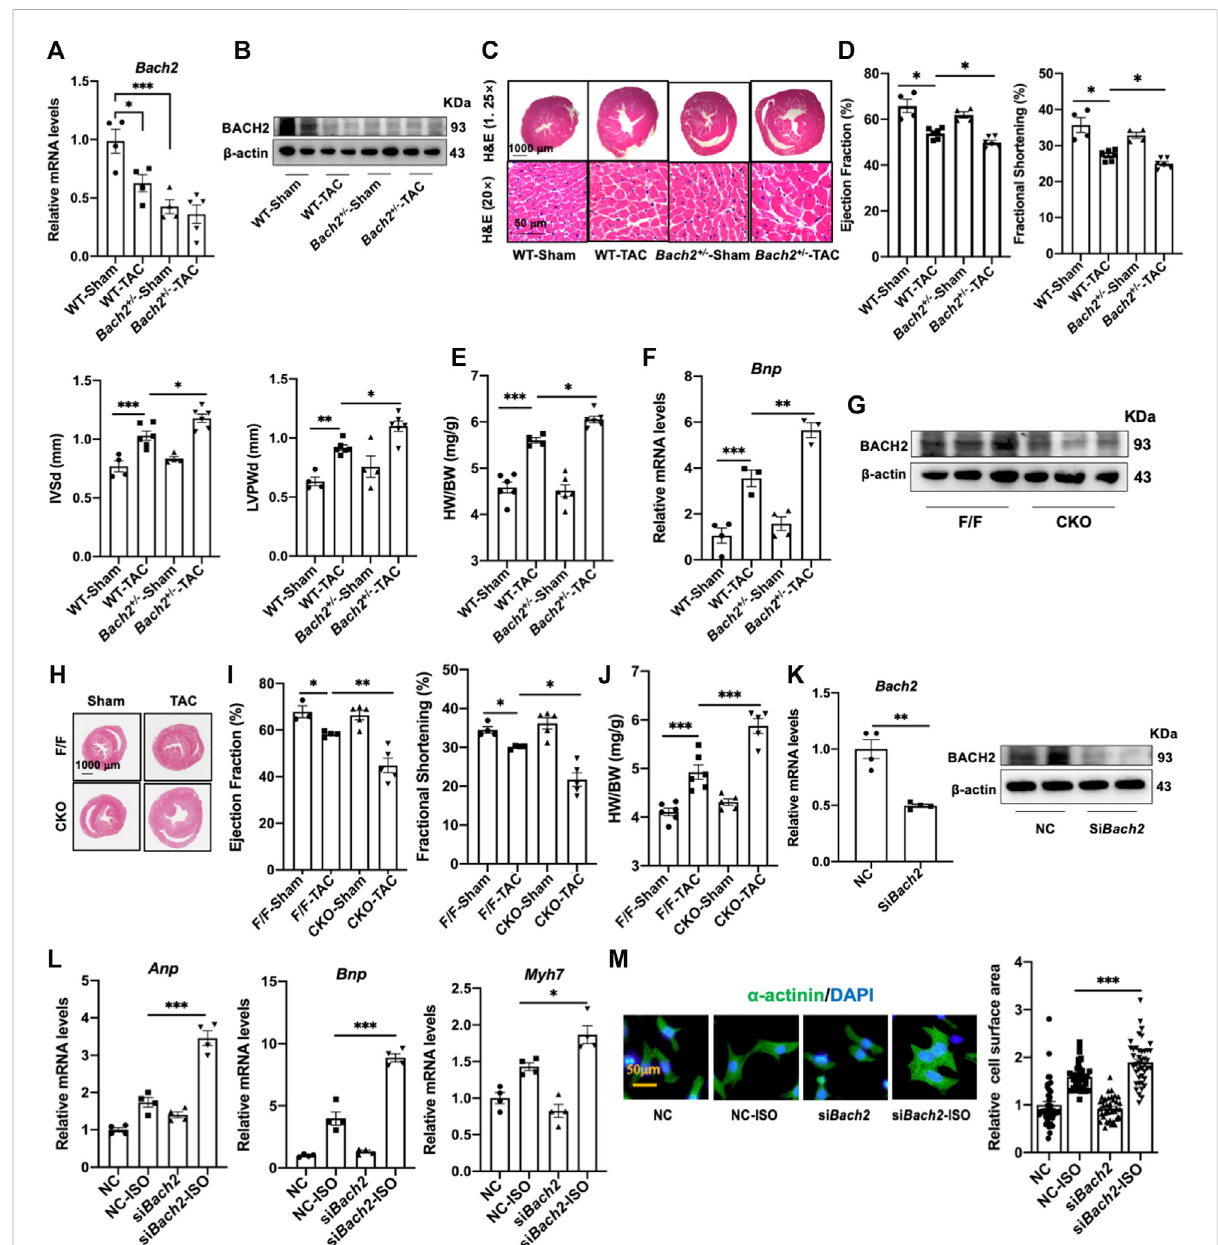
BACH2 de fi ciency exacerbates myocardial hypertrophy and dysfunction. (A – B) The Bach2 mRNA and protein expression levels. (C) H & E stain showed the hypertrophic hearts. (D) Echocardiographic analyses of cardiac wall thickness and function. (E) Heart weight/Body weight (HW/BW). (F) RT-qPCRanalysesofthe Bnp mRNAexpressionlevel. (G) TheproteinexpressionlevelofBACH2inconditional Bach2 knockoutmicecomparedwith Flox/F/ox mice. (H – J) H & Estain,Heartweight/Bodyweight(HW/BW)andechocardiographicanalysesofcardiacfunction. (K) The Bach2 mRNA and protein levels in NRVMs after transfected with siRNA targeting Bach2 (siBach2) or negative control (NC). (L) RT-qPCR analyses showed that Bach2 silence decreased the mRNA levels of Anp, Bnp and Myh7. (M) Representative a α actinin staining immuno fl uorescence images of NRVMs treated with 10 µM ISO for 24h after transfected with siBach2 or NC and quantitative analysis of cell surface area. * P < 0.05, ** P < 0.01, *** P <